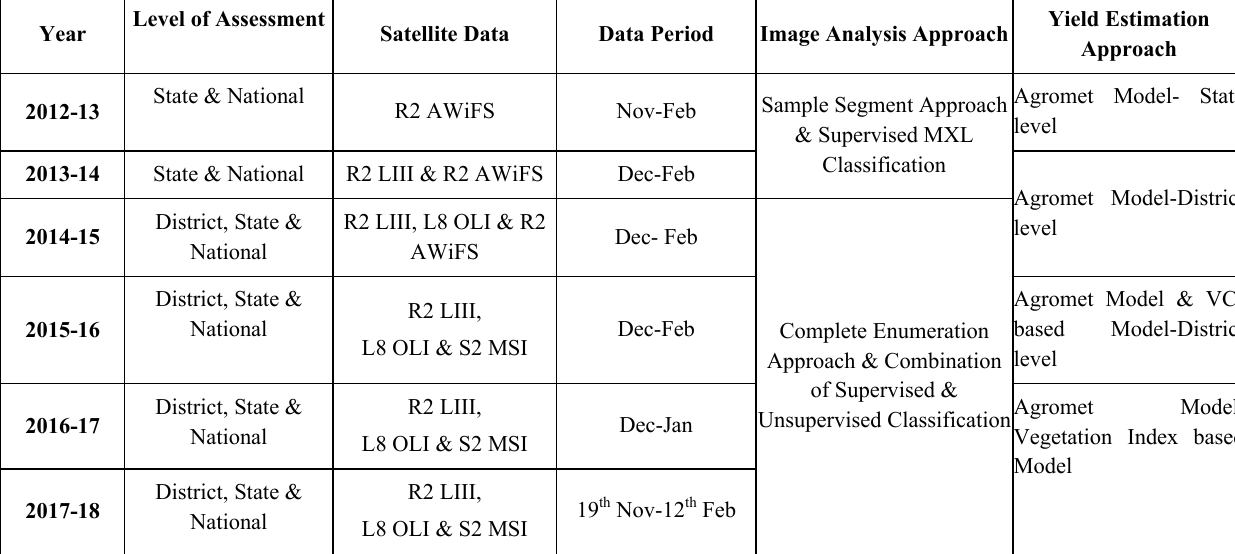
Table 3. Summary of Potato Crop Estimation Process